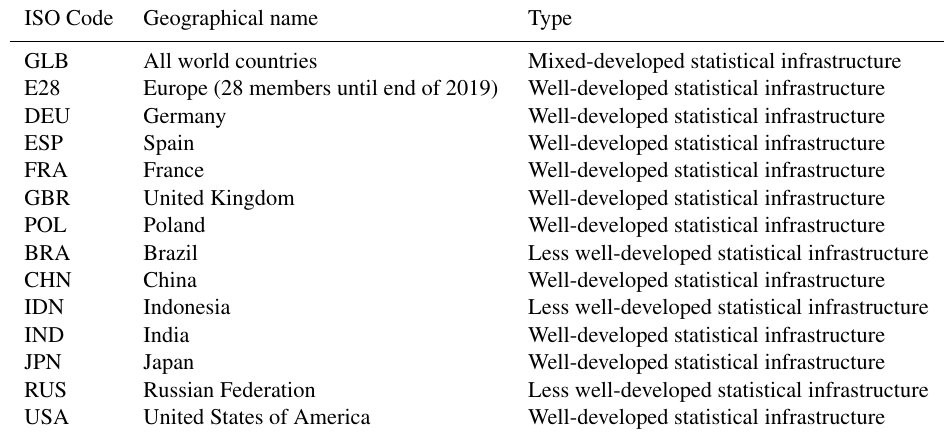
Table 6. List of selected geographical entities with their statistical infrastructure’s development levels. ISO